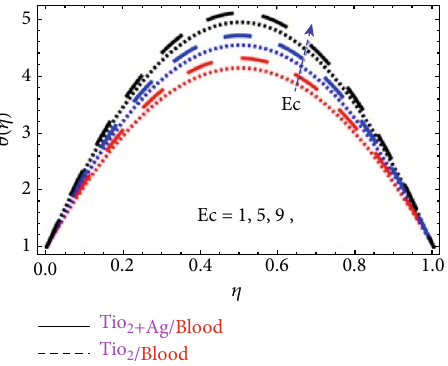
Figure 6: Inspiration of Grashof number G pro fi le.